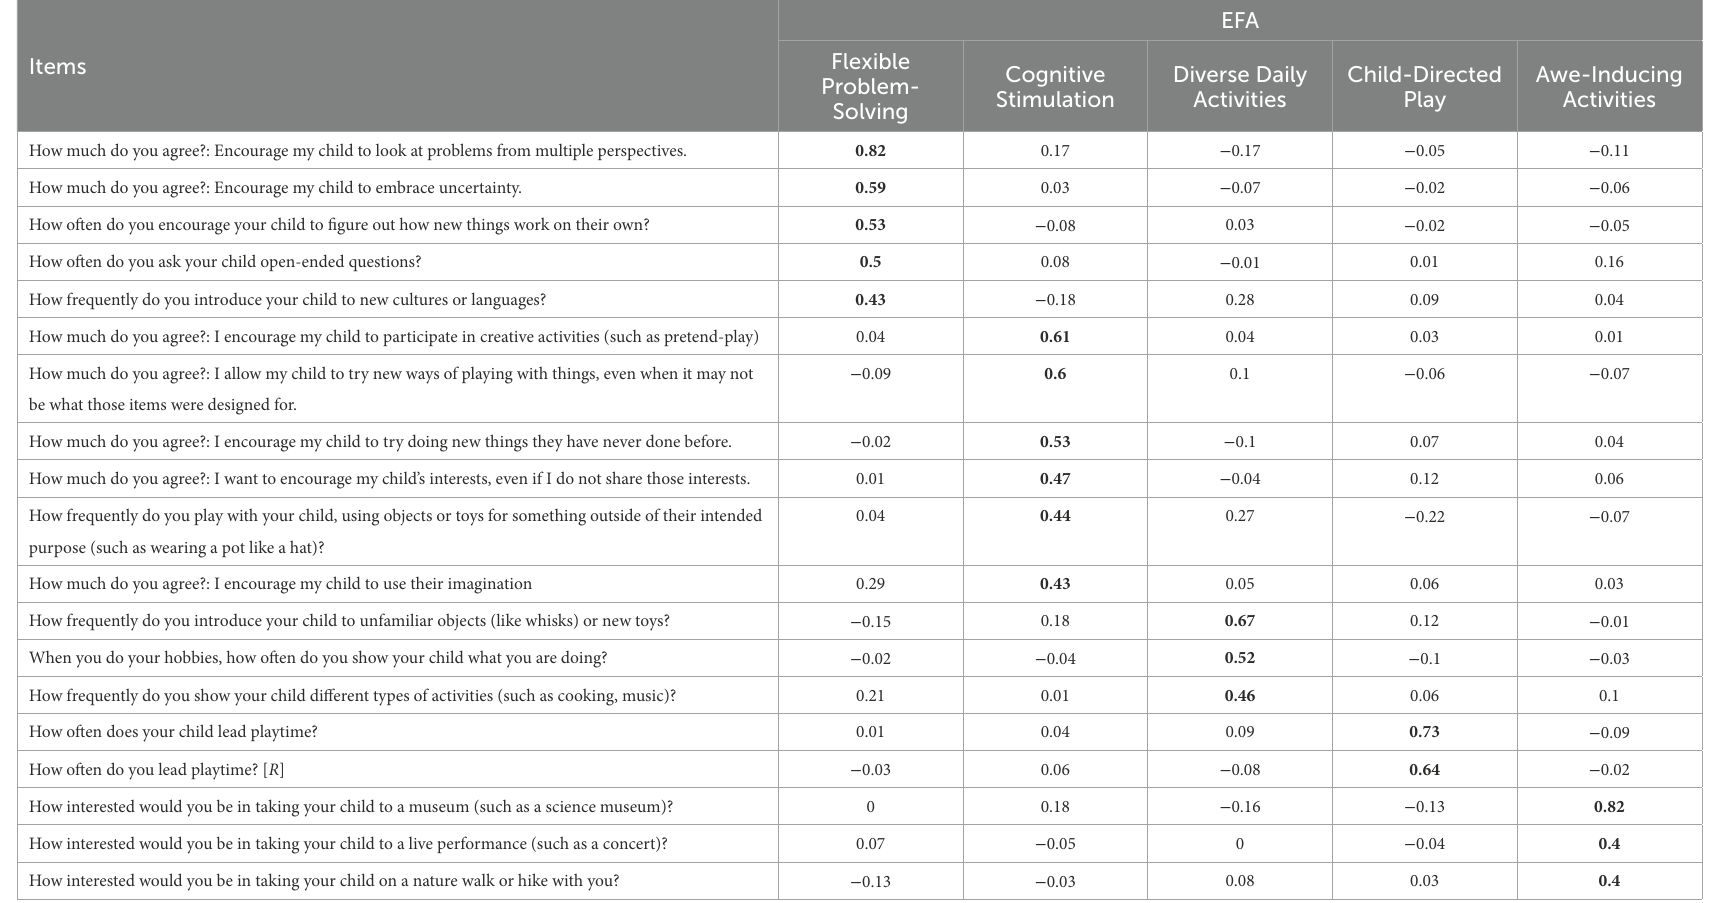
TABLE 4 Factor loadings for the final 19 items of the Caregiver Activity Subscale. Items